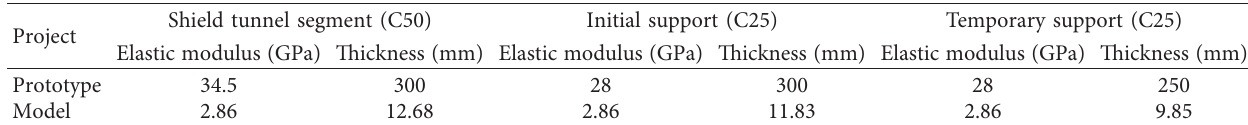
Table 5: Thickness of acrylic models.